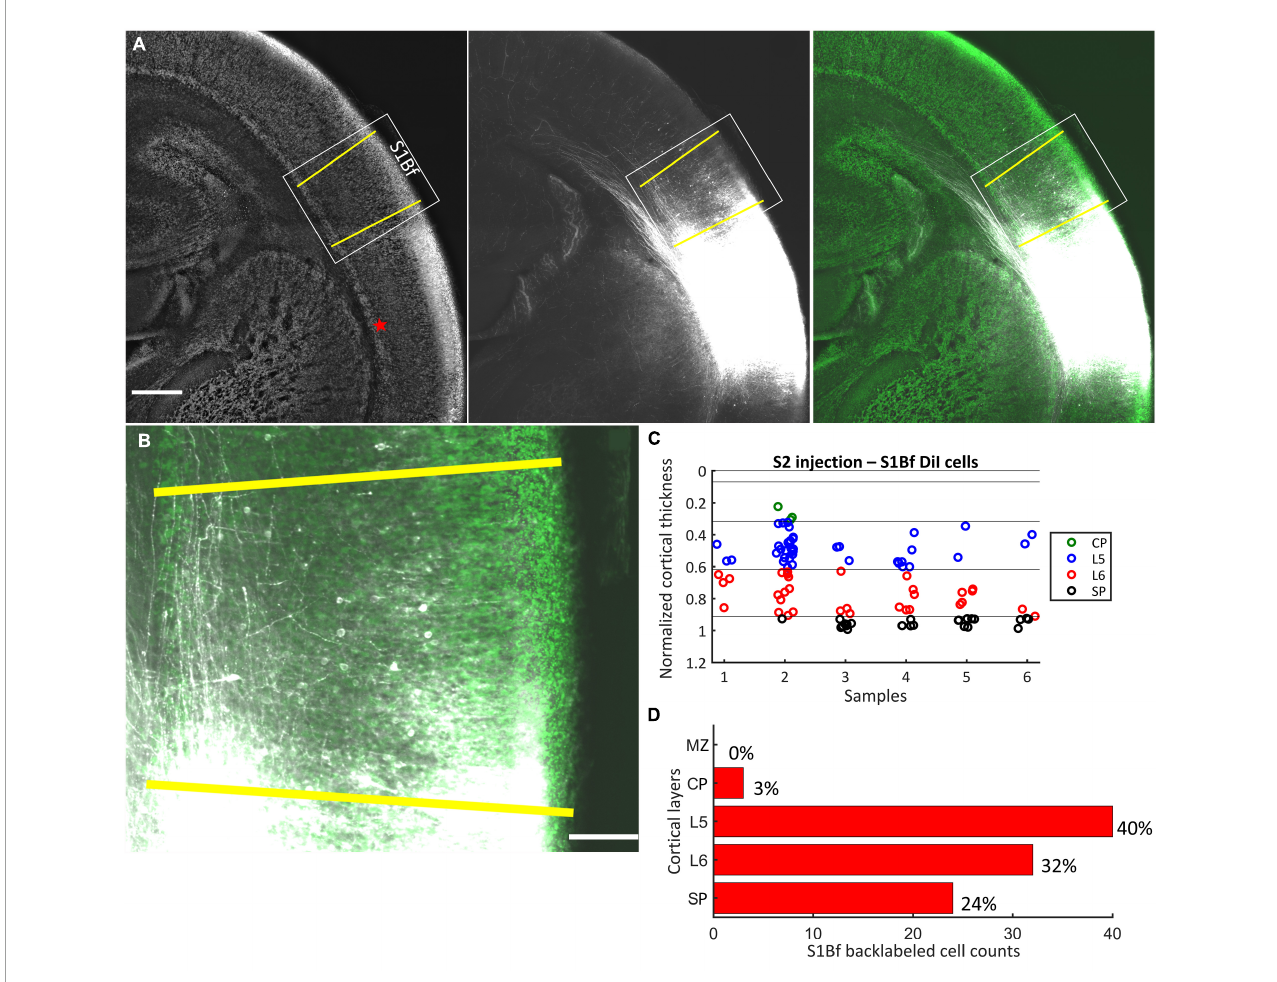
FIGURE3 DiI labeling pattern and localization of DiI backlabeled cells in S1Bf on six S2 injected samples. (A) Representative photomicrograph showing the DiI labeling pattern in S1Bf on S2 injected sample. Image was prepared as a maximum intensity projection of selected stacks of 350 µ m thick sample. Left panel: NeuN counterstain of DiI injected sample. Red asterisk indicates the DiI injection site in S2. Yellow lines demark S1Bf from the adjacent primary somatosensory cortices, according to reference points in the developing mouse brain atlas (Paxinos, 2007). Middle panel: DiI tracer spreading pattern toward S1Bf. Right panel: Composite image of the DiI signal and the NeuN signal showing the DiI spread toward S1Bf. (B) Representative S1Bf area, as indicated in the rectangle on panel (A) , showing backlabeled cell distribution across cortical layers. Scale bars are 500 µ m (A) and 100 µ m (B) . (C) Scatter plot showing the localization of manually detected somata of backlabeled cells through the normalized cortical thickness in six S1Bf injected samples. Zero level at the y axis refers to the pial surface, level 1 indicates the SP-white matter boundary. (D) Quantification of observed counts of backlabeled cells in